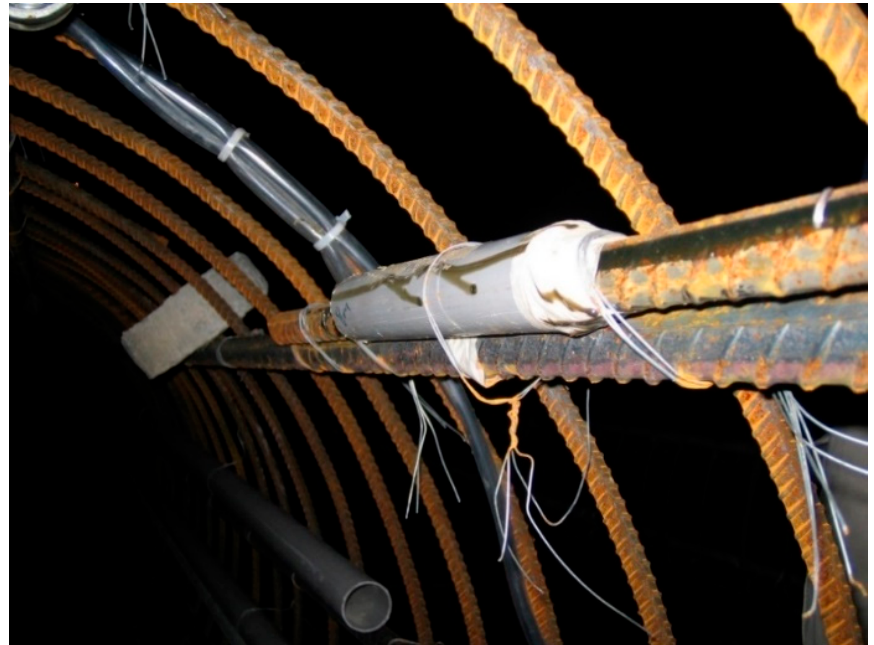
Figure 7. VWSG attached to the steel cage.